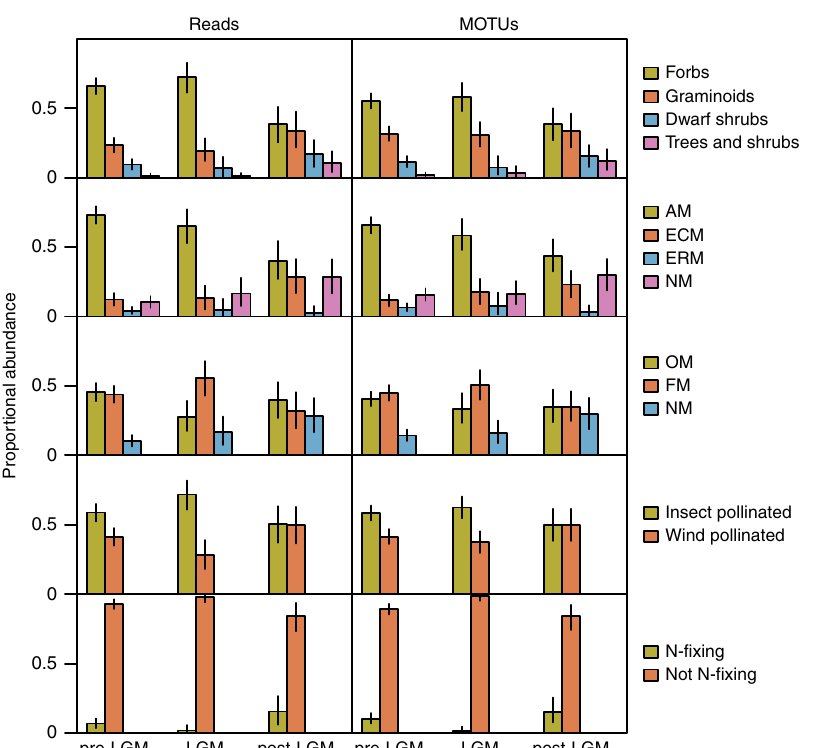
Fig. 1 Functional structure of past northern high-latitude vegetation. Representation of growth forms, mycorrhizal types, mycorrhizal statuses, pollination types and N- fi xing taxa among plants recorded from permafrost samples ( n = 216) dated to three climatic periods (pre-LGM, n = 145; LGM, n = 32; post- LGM, n = 39) during the late Quaternary. The proportional abundance of DNA sequence reads and MOTUs (molecular operational taxonomic units) is shown. Error bars show bootstrapped 95% con fi dence